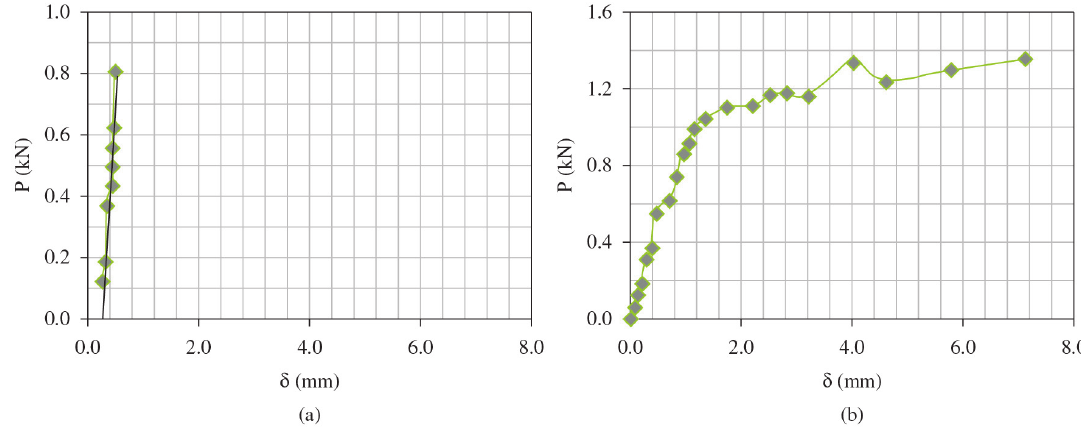
Figure 5. Typical load deflection curves obtained in four point bending of precracked beams for plain concrete (a) and fiber reinforced concrete